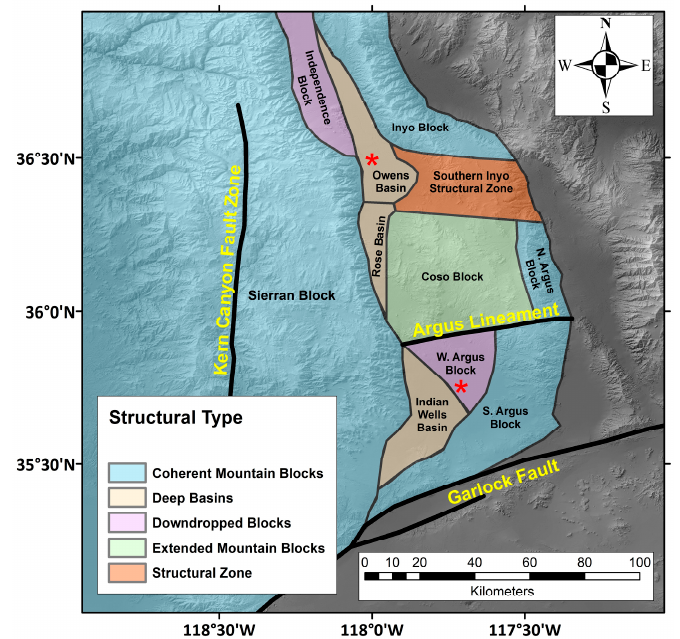
Figure 2. Southern Sierran structural types, major faults and lineaments. Red asterisks indicate approximate positions of the earthquake epicenters reported herein. Both earthquake shocks radiated across deep basins and produced severe shaking in the study areas in the Sierran Block (See Figure 1 for more detailed fault traces). The Sierra Nevada range front fault zone (not shown) runs along the western edges of the Indian Wells, Rose and Owens Basin Blocks (after [27]).